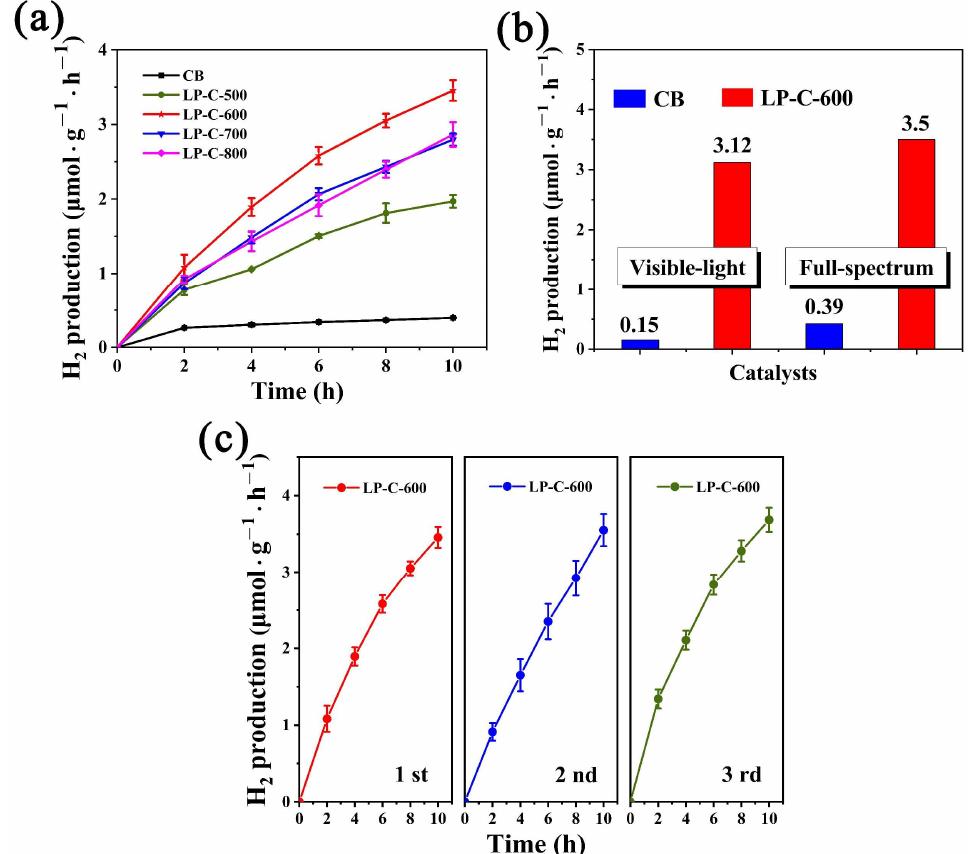
Figure 6. ( a ) H 2 evolution performance of samples, ( b ) comparison of H 2 evolution performance of samples under visible light and full spectrum, and ( c ) H 2 evolution stability of LP-C-600.